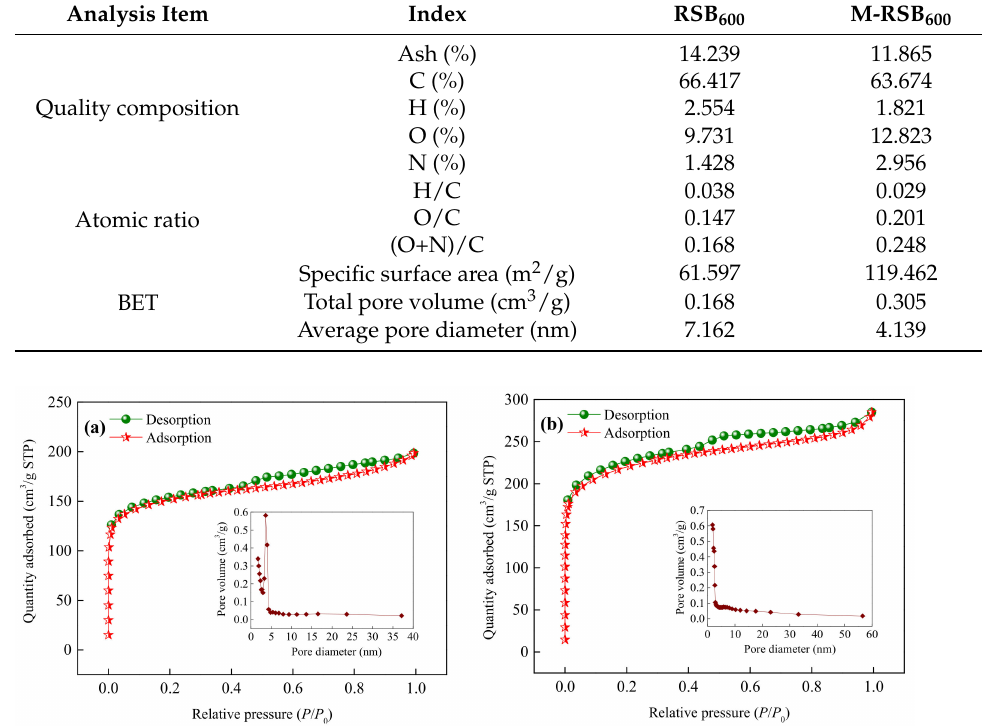
Figure 2. N 2 adsorption–desorption isotherm and pore size distribution curve of RSB 600 ( a ) and M-RSB 600 ( b